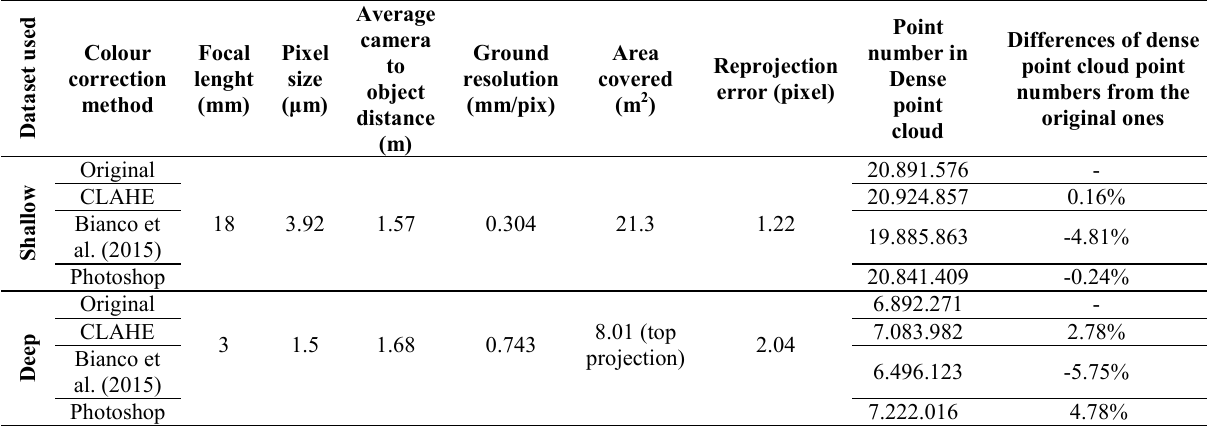
Table 1: Results of the SfM - MVS procedure for medium quality dense cloud